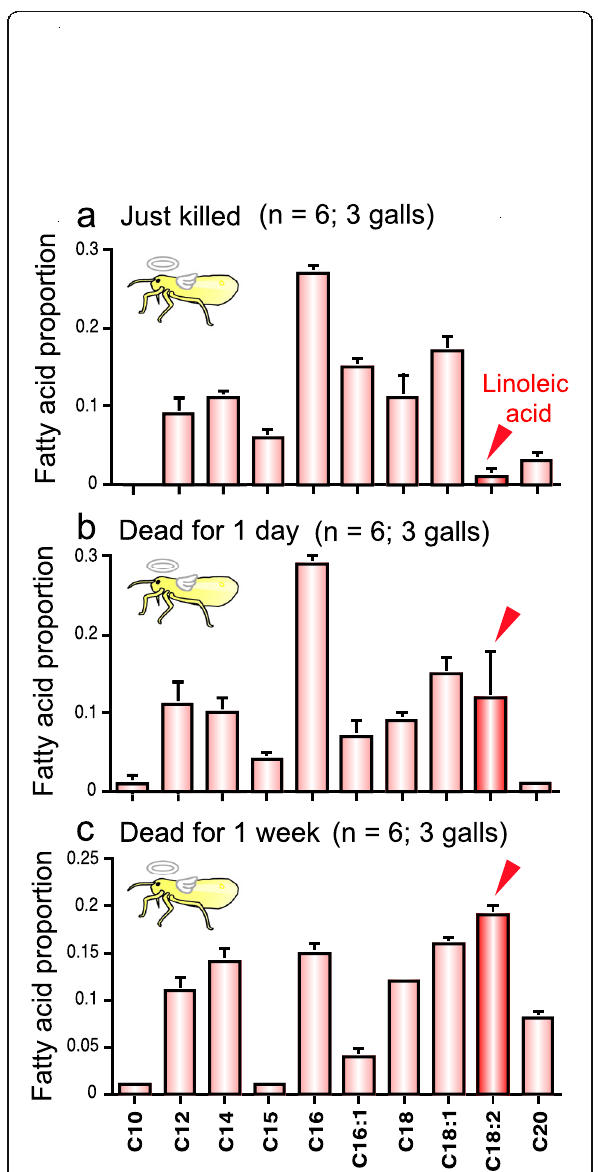
Fig. 5 Bioassay of factors that trigger the cleaning behavior of soldiers of T. styraci . ( a ) Schematic illustration of the experimental system. ( b ) Results of the bioassay (also see Fig. 6). Lauric acid, myristic acid, palmitic acid, stearic acid, oleic acid and linoleic acid were tested alone or blended at the ratios of 0.6: 0.8: 1.1: 0.8: 1.0: 1.0, which mimick the cuticular fatty acid profile of 1-week-old dead adult